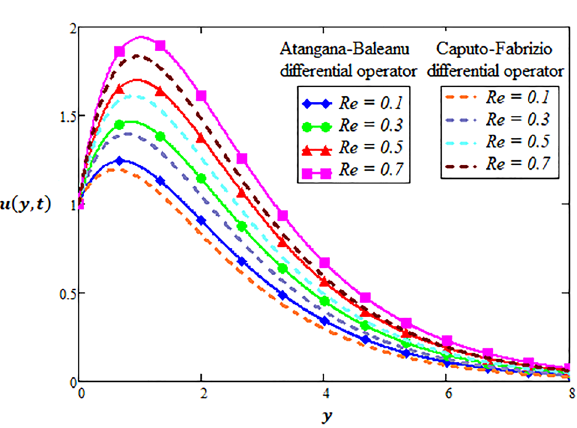
Figure 6. Variation of Reynold number for two-dimensional velocity profile through AB-differential operator verses CF-differential